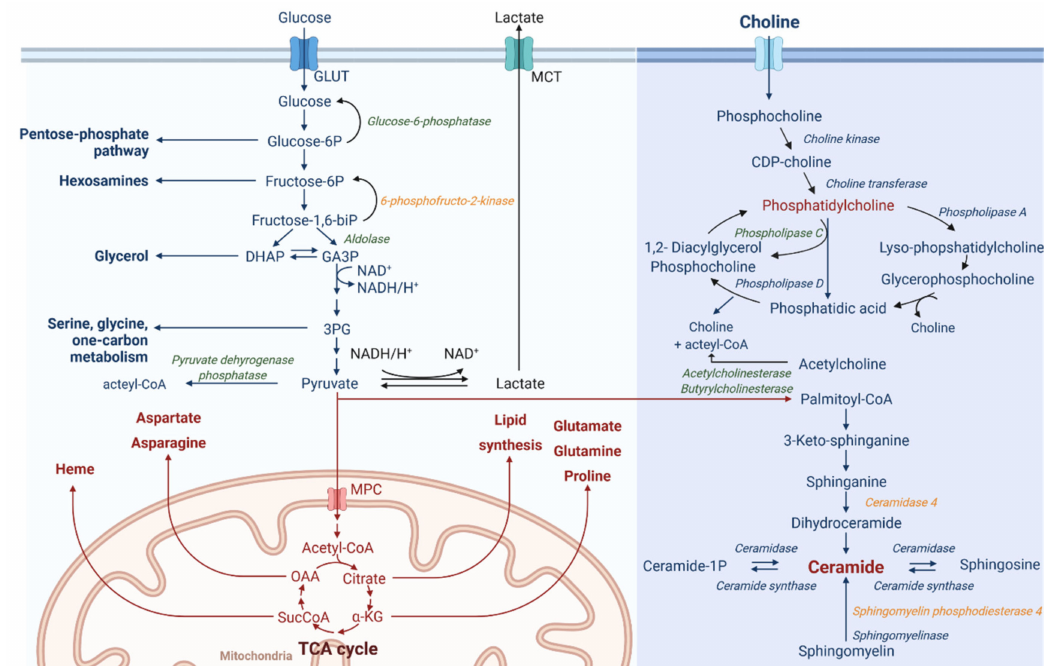
Figure 3. Schematic representation of metabolic pathways targeted by ODC REMP . RNA sequencing and LC-HRMS/MS data revealed a strong impact on metabolic pathways after ODC REMP treatment. These pathways include glycolysis, choline and ceramide metabolism. Enzymes detected to be upregulated after ODC REMP treatment (in italics and orange), downregulated enzymes (in italic and green), and upregulated metabolites (written in red). Pyruvate can be used for the enzymatic conversion of palmitoyl-CoA, which is the primary molecule to initiate the de novo synthesis of ceramide. Molecules of the ceramide class were significantly upregulated, as well as the two enzymes ceramidase 4 and sphingomyelin phosphodi- esterase 4. Pyruvate is also the substrate for pyruvate dehydrogenase phosphatase producing acetyl-CoA. This figure was created with BioRender.com. Legend: α KG, α -ketoglutarate; 1/6(bi) p , 1/6 (bis)phosphate; 3PG, 3-phosphoglyceric acid; CDP-choline, cytidine 5 (cid:48) -diphosphocholine; CoA, coenzyme A; DHAP, dihydroxyacetone phosphate; GA3P, glyceraldehyde 3-phosphate; GLUT, glucose transporter; MCT, monocarboxylate transporter; MPC, mitochondrial pyruvate carrier 1; NAD, nicotinamide dinucleotide; OAA, oxaloacetate; SucCoA, succinyl-CoA; TCA, citric acid